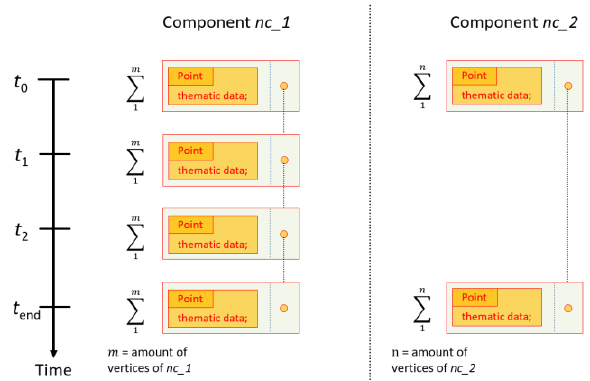
Figure 4. Internal structure representing the management of a 0D-net, which is composed of two components with different temporal